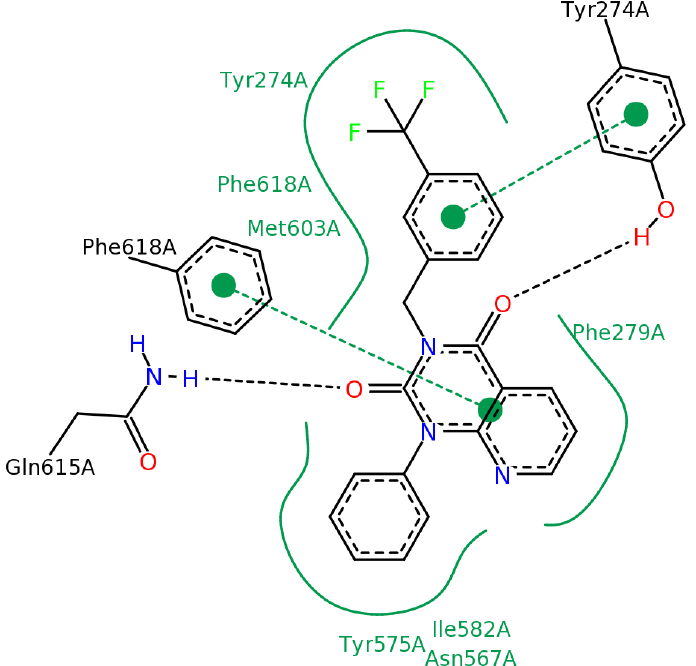
Figure 14. Diagram of the most important interactions in the Glide XP calculated PDE4B—#3 (2nd round hit) complex identified by PoseView. Black dashed lines represent hydrogen bonds, green solid lines represent hydrophobic interactions and green dashed lines represent aromatic